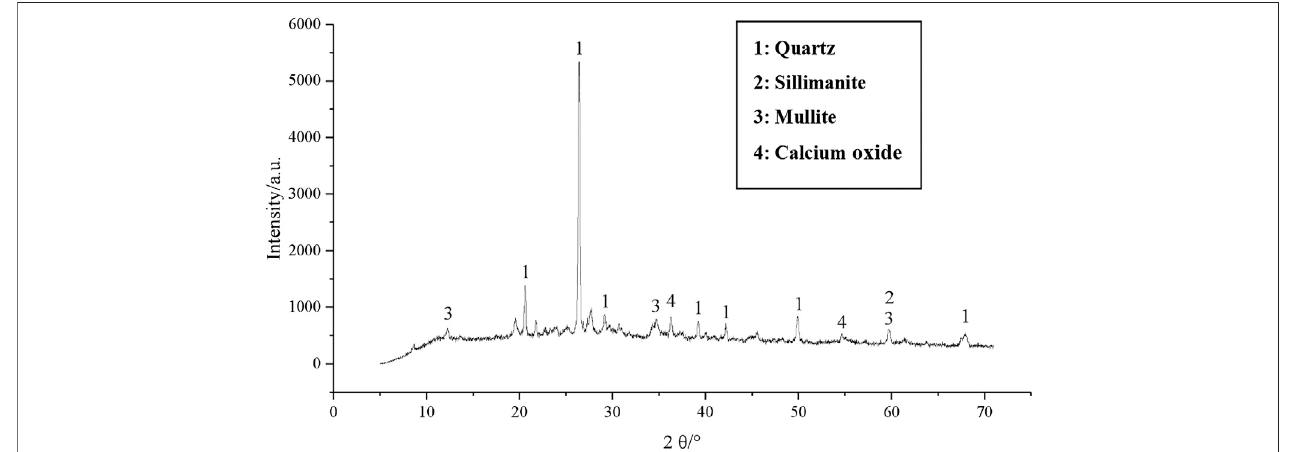
FIGURE 16 | XRD pattern of the one-part geopolymer-stabilized soft clay with 90% GGBFS and 10% FA at 4.64 mol/L NH solution for 14 days.